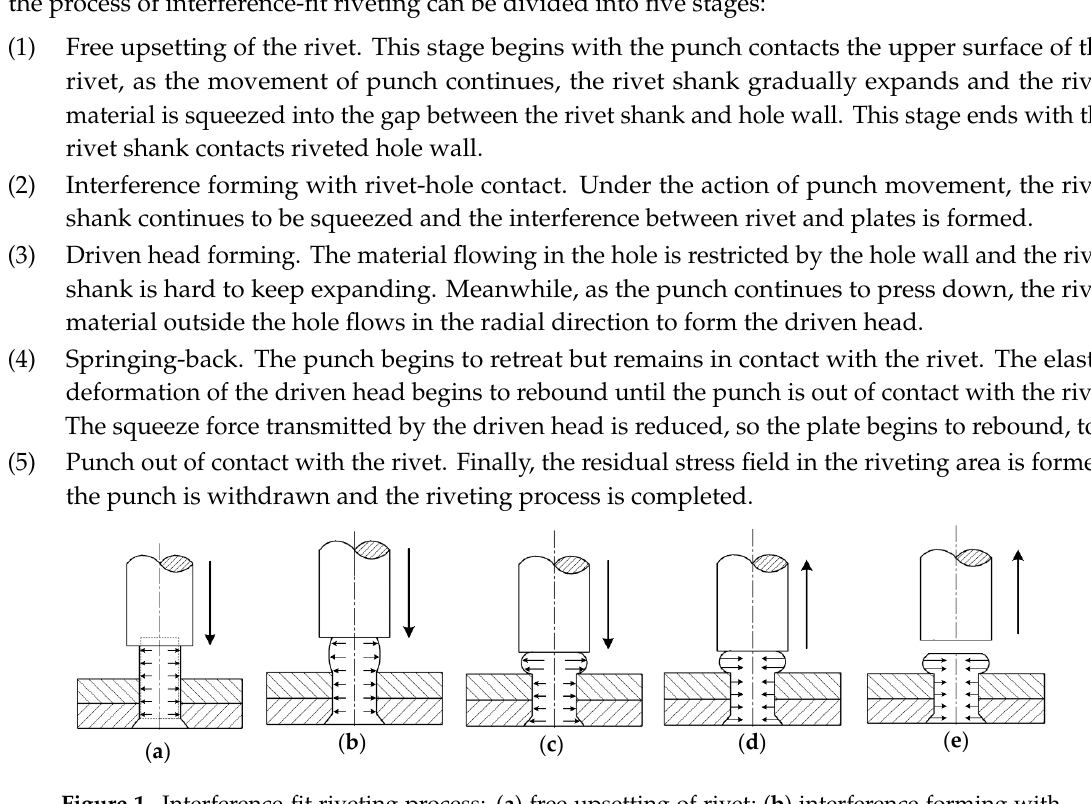
Figure 1. Interference-fit riveting process: ( a ) free upsetting of rivet; ( b ) interference forming with rivet-hole contact; ( c ) driven head forming; ( d ) springing-back; ( e ) punch out of contact with rivet.